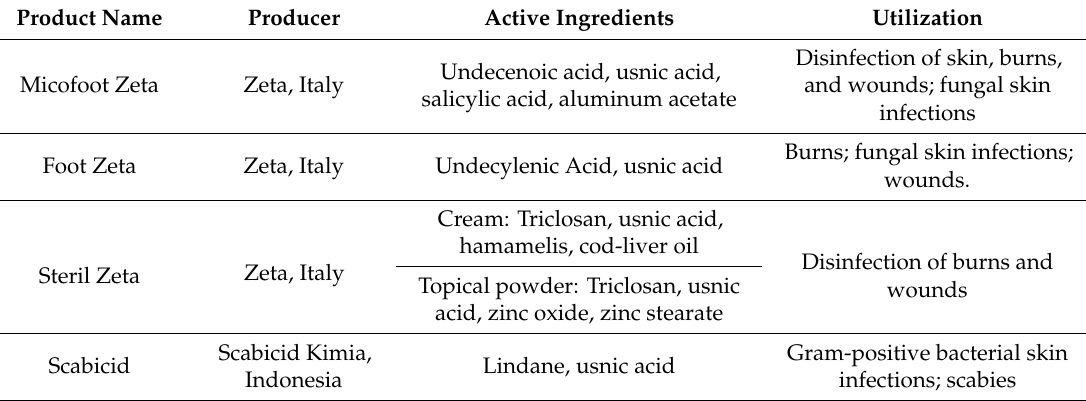
Figure 1. Pattern of scientific research on usnic acid found on Scopus: ( A ) from 1940–2019 (search was restricted to the term “usnic acid” in the abstract), ( B ) from 2005–2019 (search was restricted to the term “usnic acid” and “nanoparticles” and “microparticles” in all fields). Table 1. List of products containing usnic acid as an active ingredient